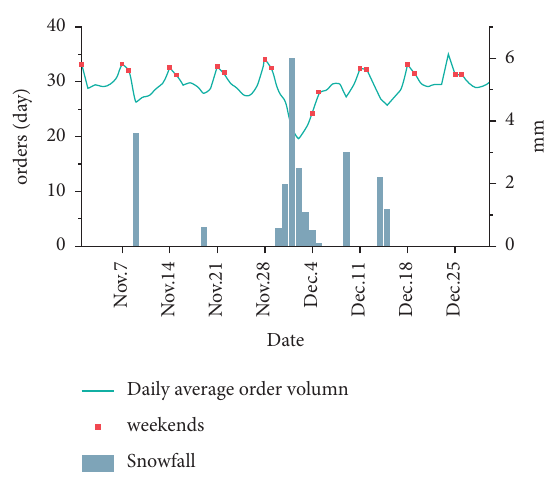
Figure 4: Plot of the DAOV and snowfall over 61 days.